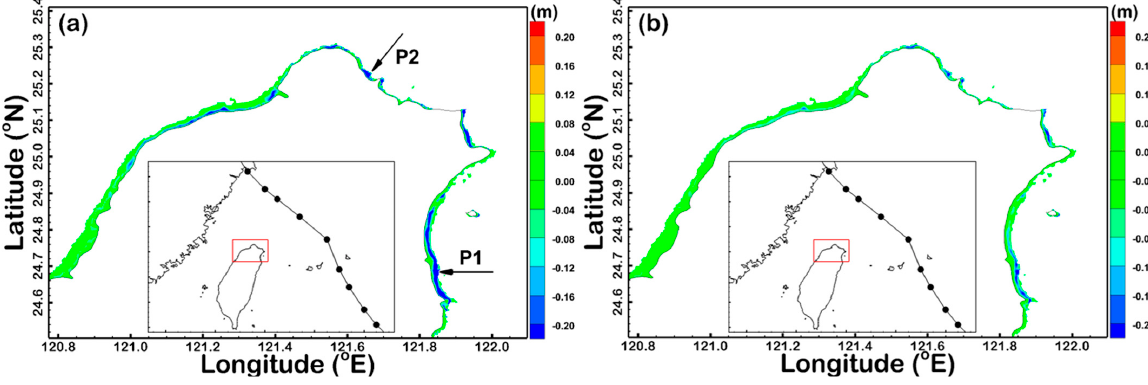
Figure 16. Time series of hindcasted SWHs for ( a ) P1 and ( b ) P2 using the S_NO1, S_NO4 and S_NO5 scenarios during the passage of Super Typhoon Lekima in 2019. 4. Discussion and Uncertainty Hindcasting an accurate storm wave height is highly dependent on the accuracy of the typhoon wind fields. Reanalysis wind products underestimate typhoon winds, e.g., Çal ı ş ı r et al. [53] evaluated the quality of ERA5 and CFSR (Climate Forecast System Rea- nalysis) winds and the contribution of reanalysis wind products to a wave modeling per- formance in a semi-closed sea. Their results revealed that ERA5 and CFSR tend to under- estimate wind speeds, and ERA5 performs worse than CFSR at higher wind speeds (such as typhoon winds) and better at lower wind speeds. Thus, the utilization of hybrid winds through the superposition method (the combination of reanalysis wind products and par- ametric cyclone wind models) or the direct modification method (the combination of rea- nalysis wind products and the maximum wind speeds of typhoons from the best track